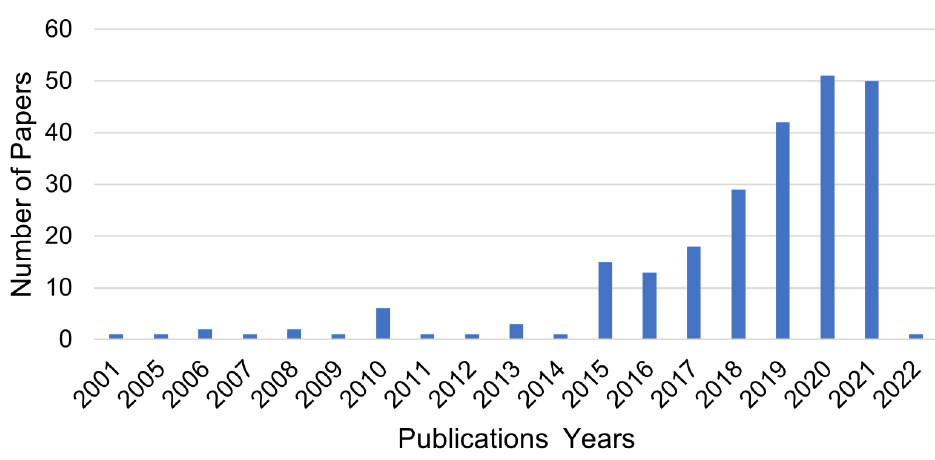
Figure 5. Distribution of publications by